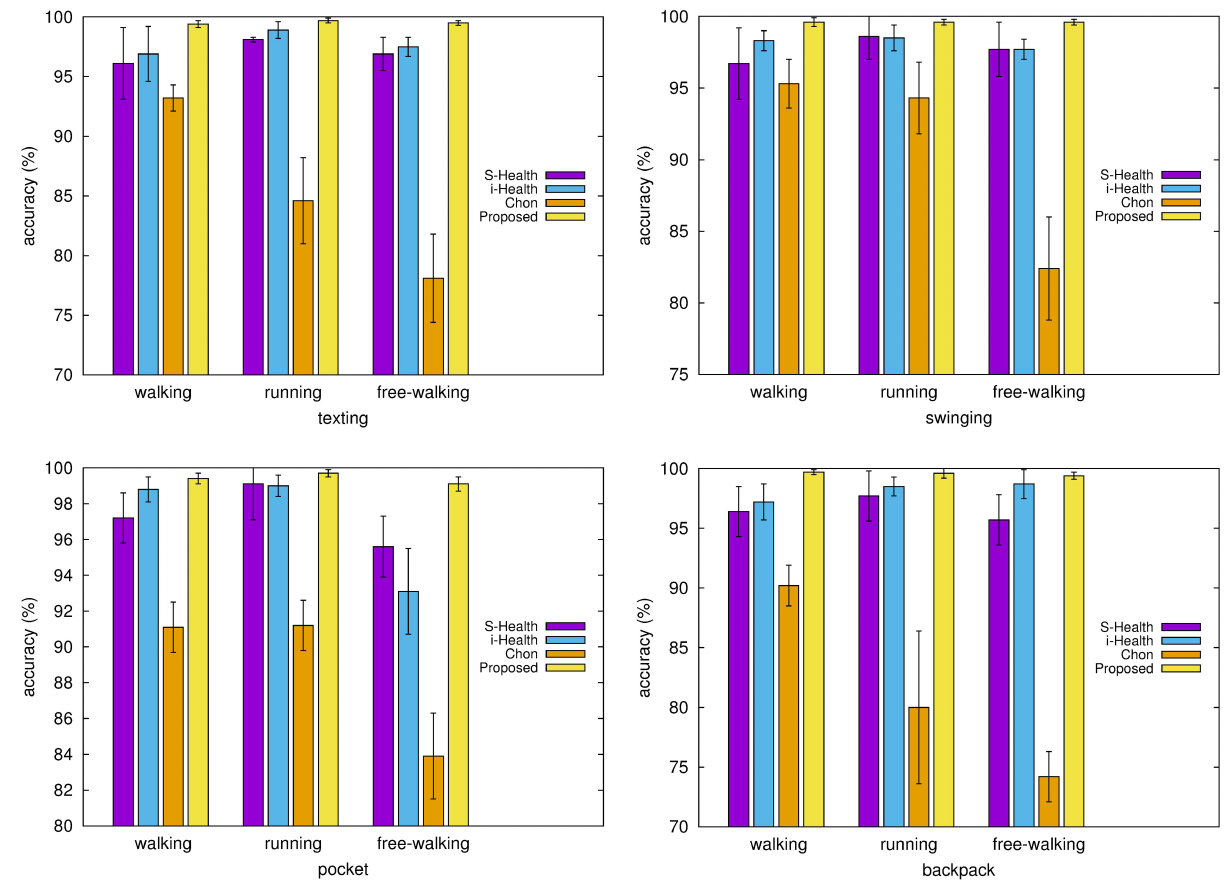
Figure 6. Performance comparison of step detection